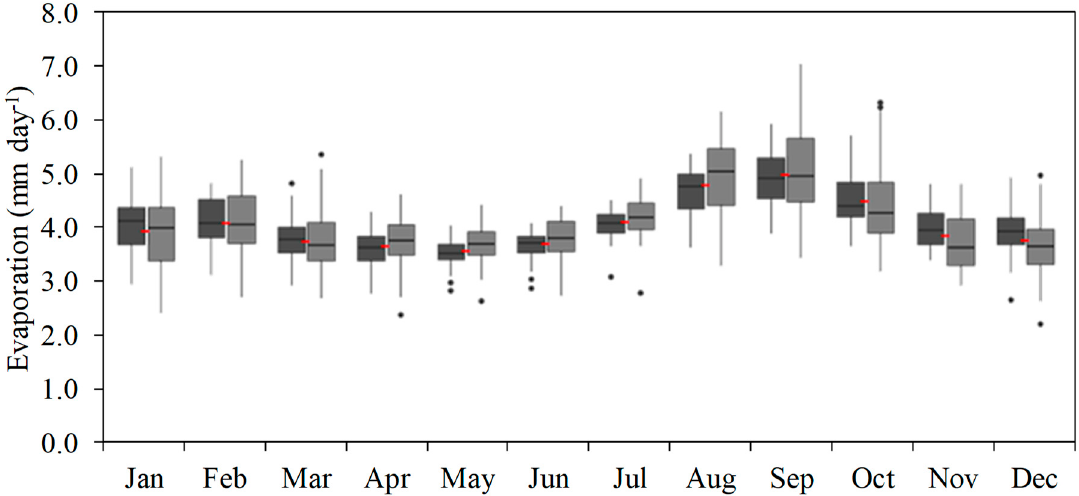
Figure 6. Monthly average evaporation estimated based on the historical series by the best performing methods—KNF: Kohler et al. (1955) and L93: Linacre (1993). The red line indicates the monthly average simulated.